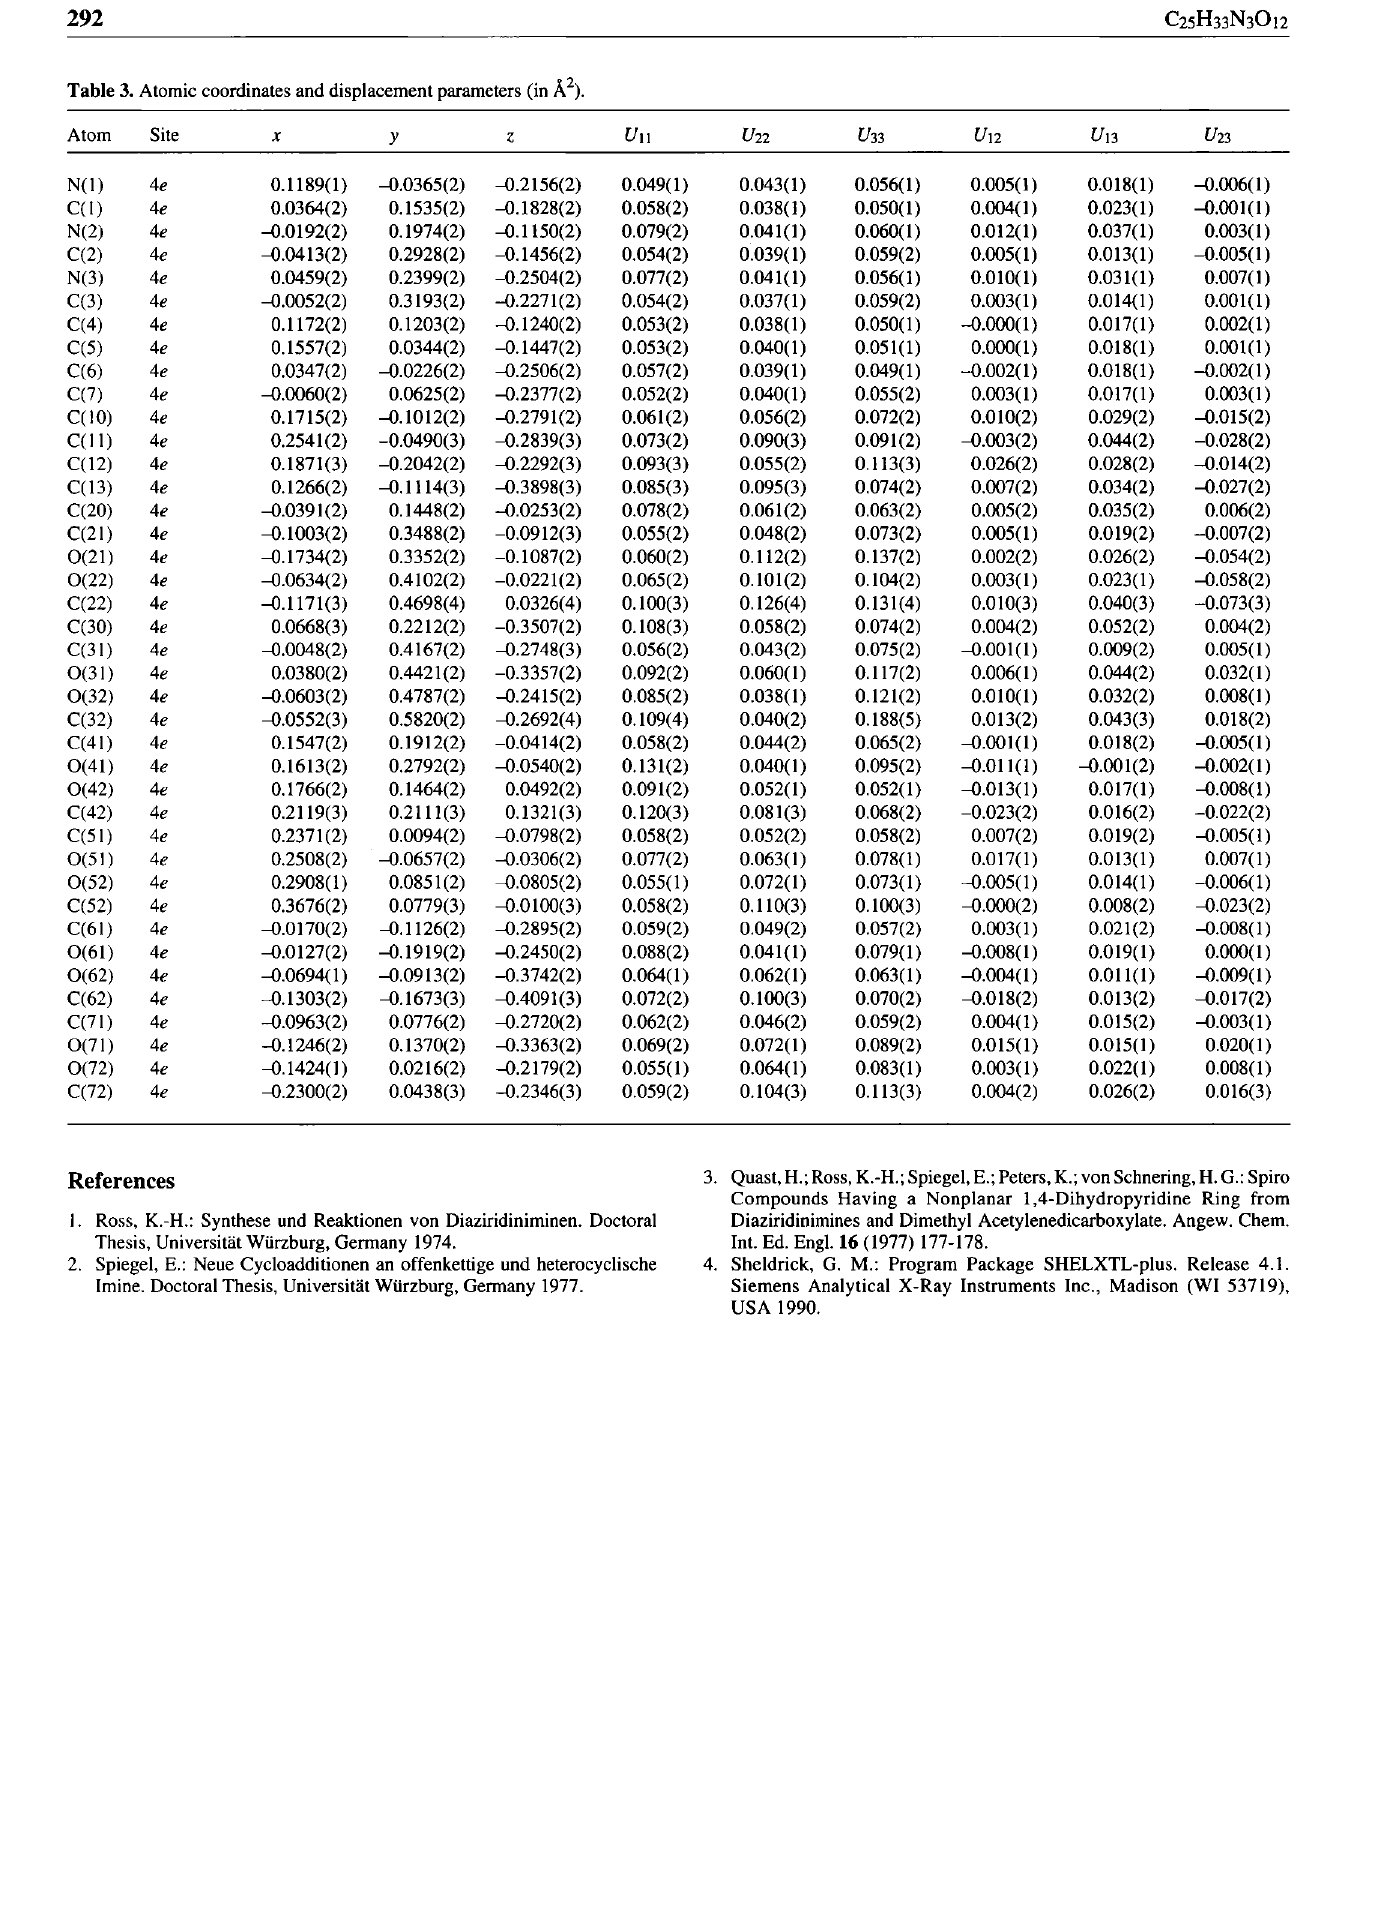
Table 3. Atomic coordinates and displacement parameters (in Ä 2